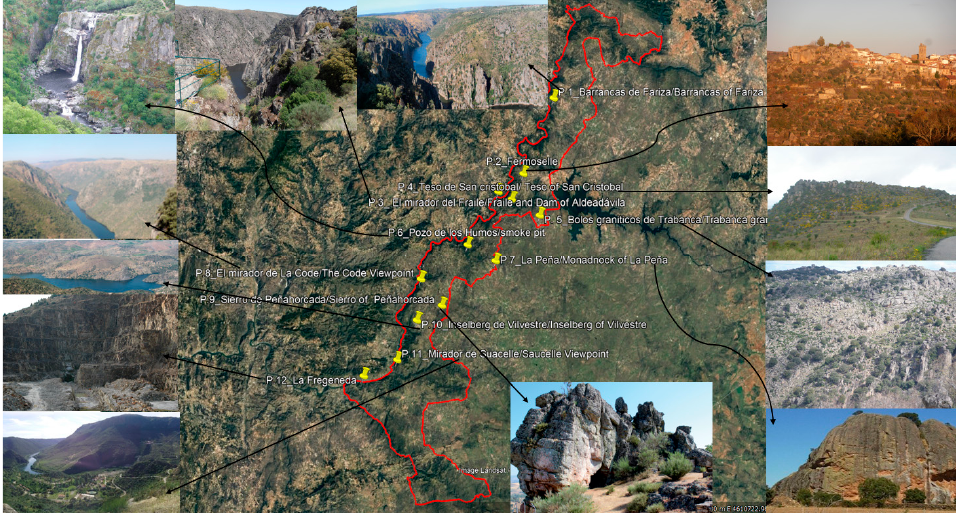
Figure 2. Arribes del Duero Natural Park with selected geological sites.